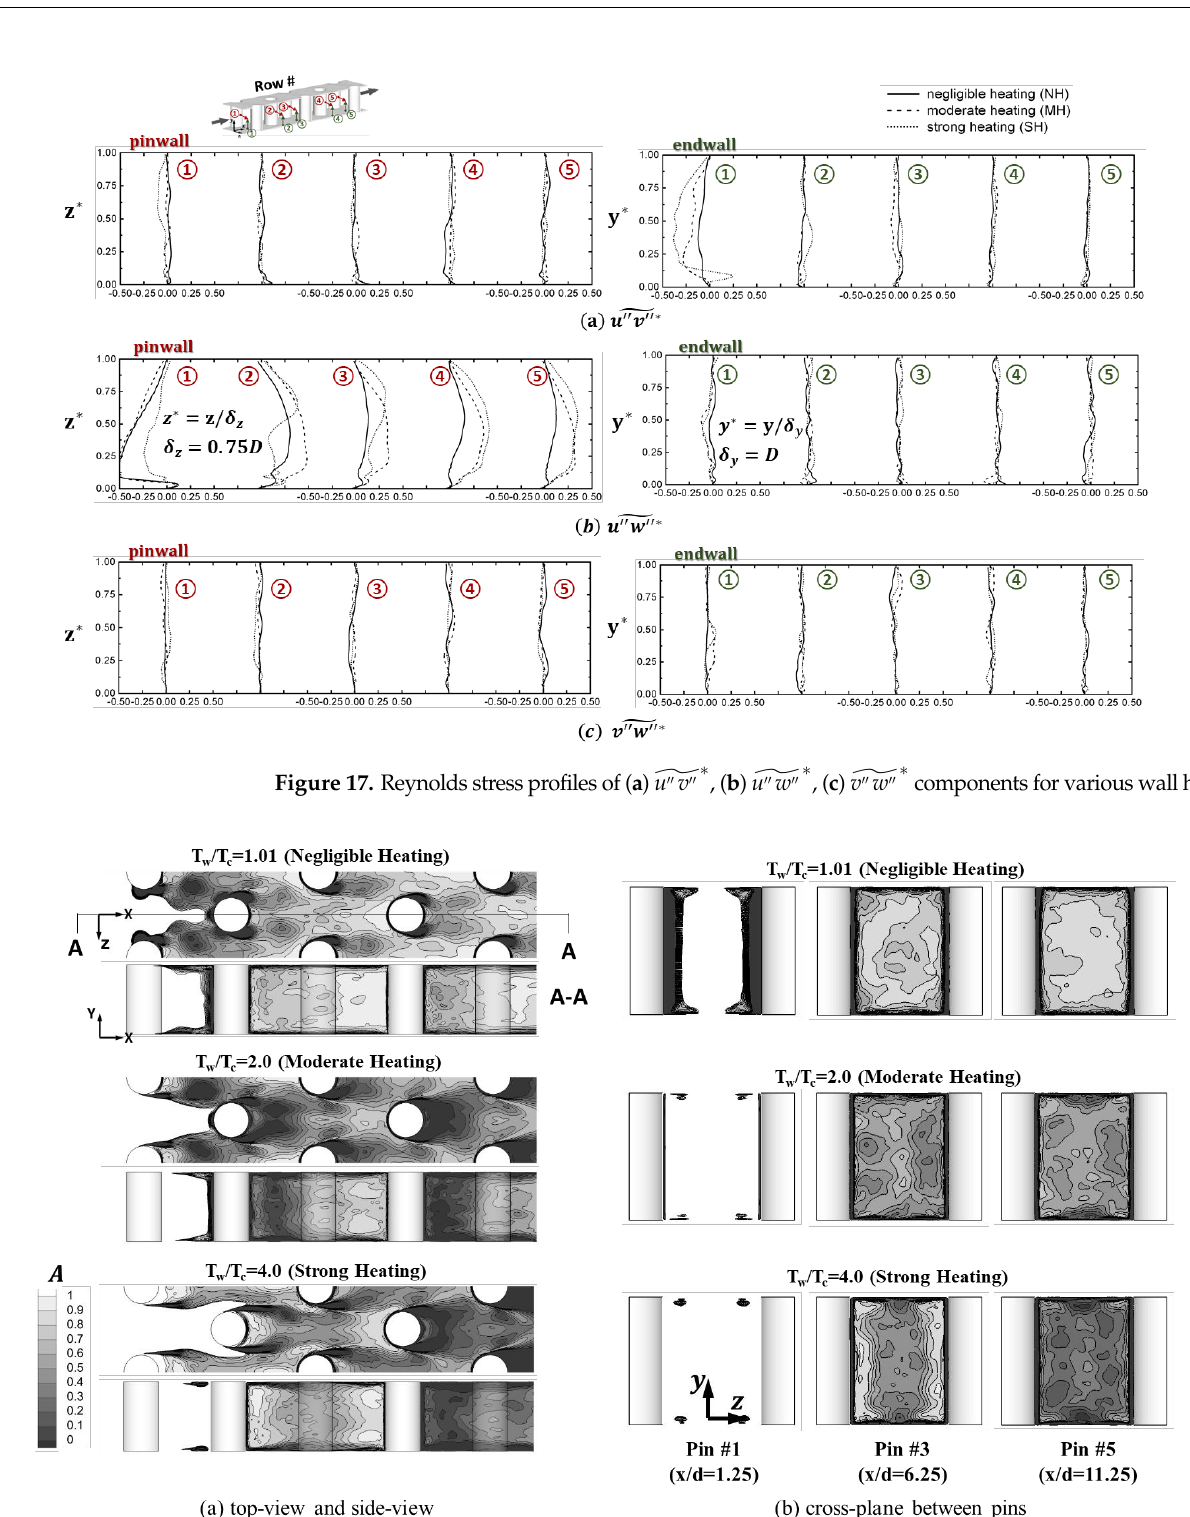
Figure 18. The distribution of the anisotropy flatness parameter, A.